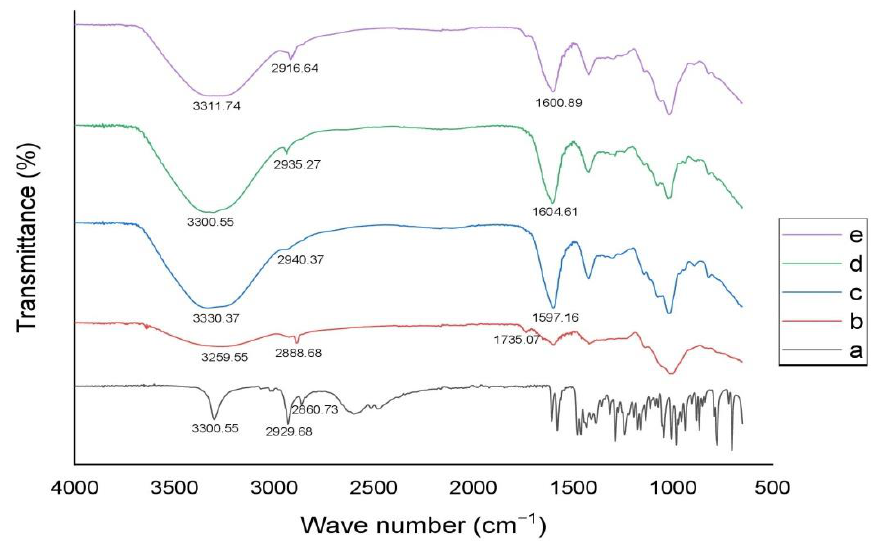
Figure 8. FTIR spectra of ( a ) TRHC ( b ) PAG ( c ) unloaded PAG-alginate microspheres ( d ) blended microspheres ( e ) coated microsphere.